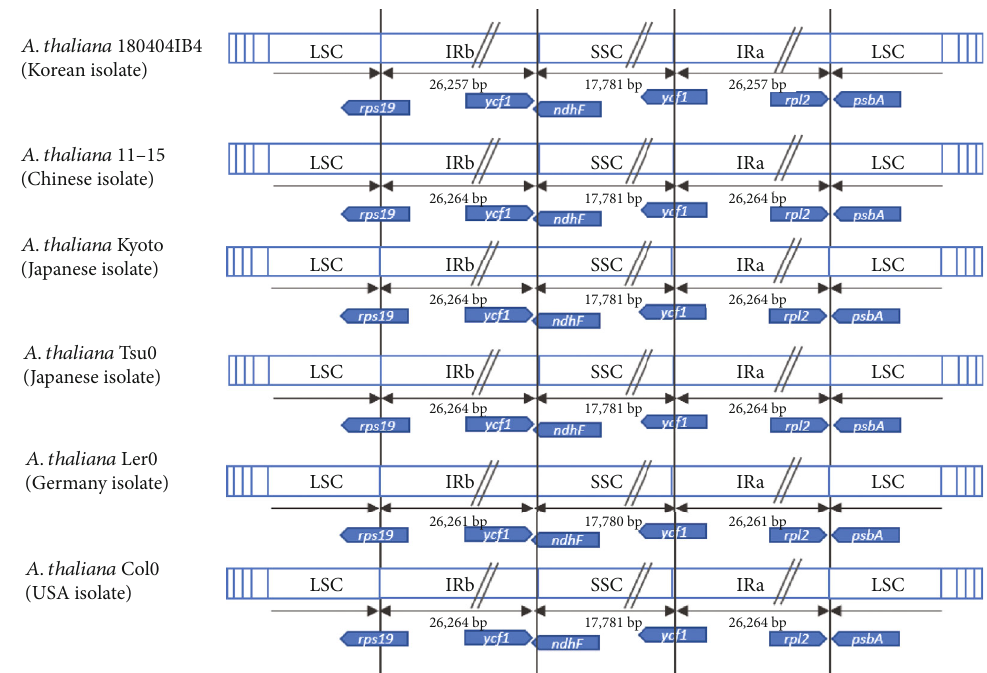
Figure 6: Structure of IR junction of six Arabidopsis thaliana chloroplast genomes. Blue diagrams present three chloroplast genomes of A. thaliana with each region. Black arrows show length of each region except LSC, and blue arrow diagrams show genes located in junctions between LSC and IRb, IRb and SSC, SSC and IRa, and IRa and